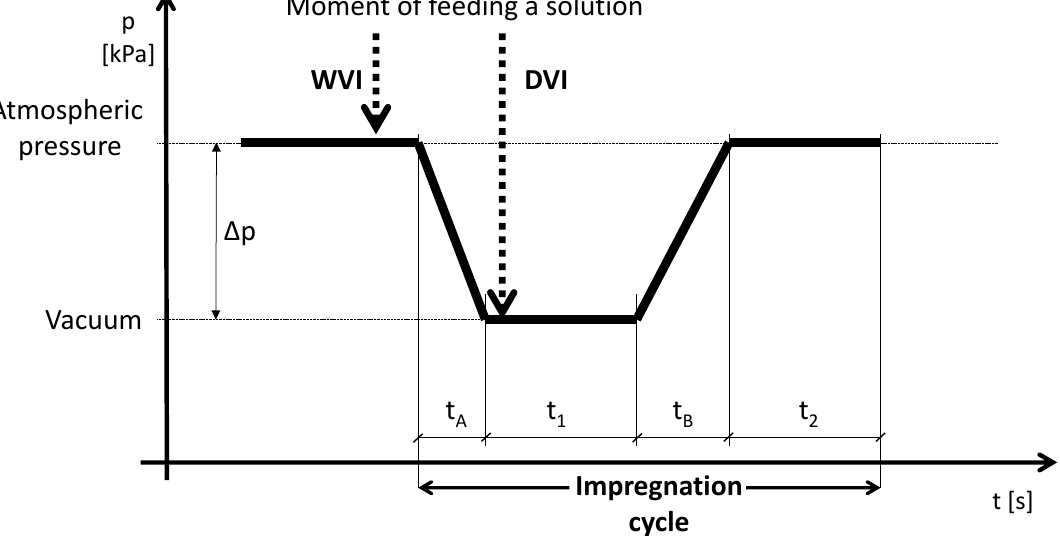
Figure 1. The process of vacuum impregnation and its phases: phase 1—pressure change during time t A , phase 2—vacuum maintenance during time t 1 , phase 3—pressure change during time t B , phase 4—relaxation during time t 2 .